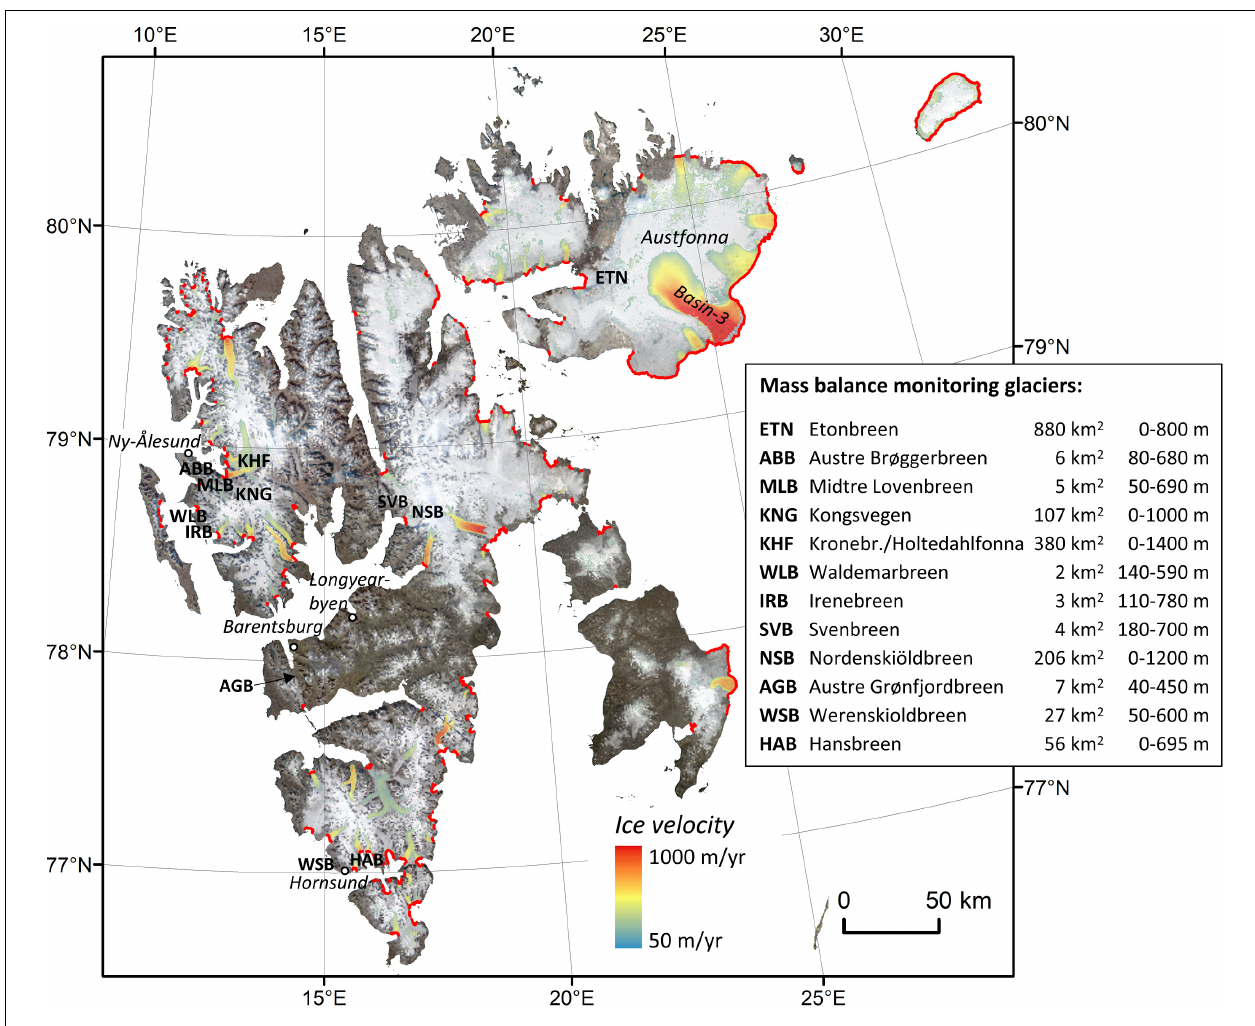
FIGURE 1 | Overview map of Svalbard, showing glacier-covered areas (white) with color-shaded surface velocities for 2018 in cases where glaciers moved faster than 50 m a − 1 . Surface velocities have been retrieved from the NASA MEaSUREs ITS_LIVE project (Gardner et al., 2019). The red coastal lines show termini of tidewater glaciers from 2018. The background image is a Landsat-mosaic from toposvalbard.npolar.no. Abbreviated labels show the location of present glaciological mass balance monitoring glaciers on Svalbard, along with glacier area and elevation